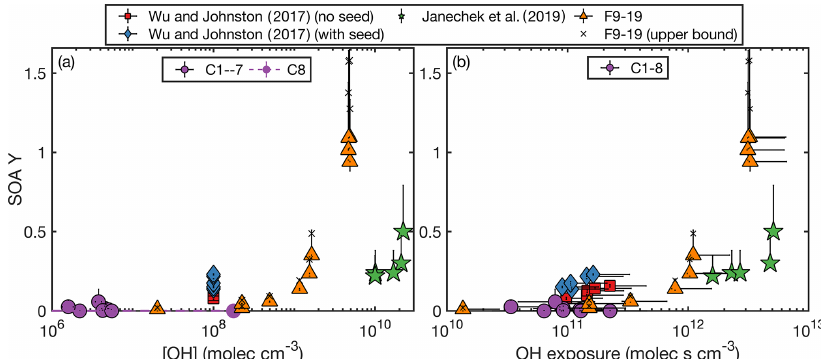
Figure 1. Measured SOA yield as a function of the (a) OH concentration and (b) OH exposure for the experiments performed here and by Janechek et al. (2019) and Wu and Johnston (2017). In panel (a) , C8, which was performed with methyl nitrite, is shown in purple and not outlined in black and the initial and final OH concentrations are connected with a dashed purple line. The vast majority of this experiment was performed under the lower OH concentration. The same OH concentration is used for all experiments from Wu and Johnston